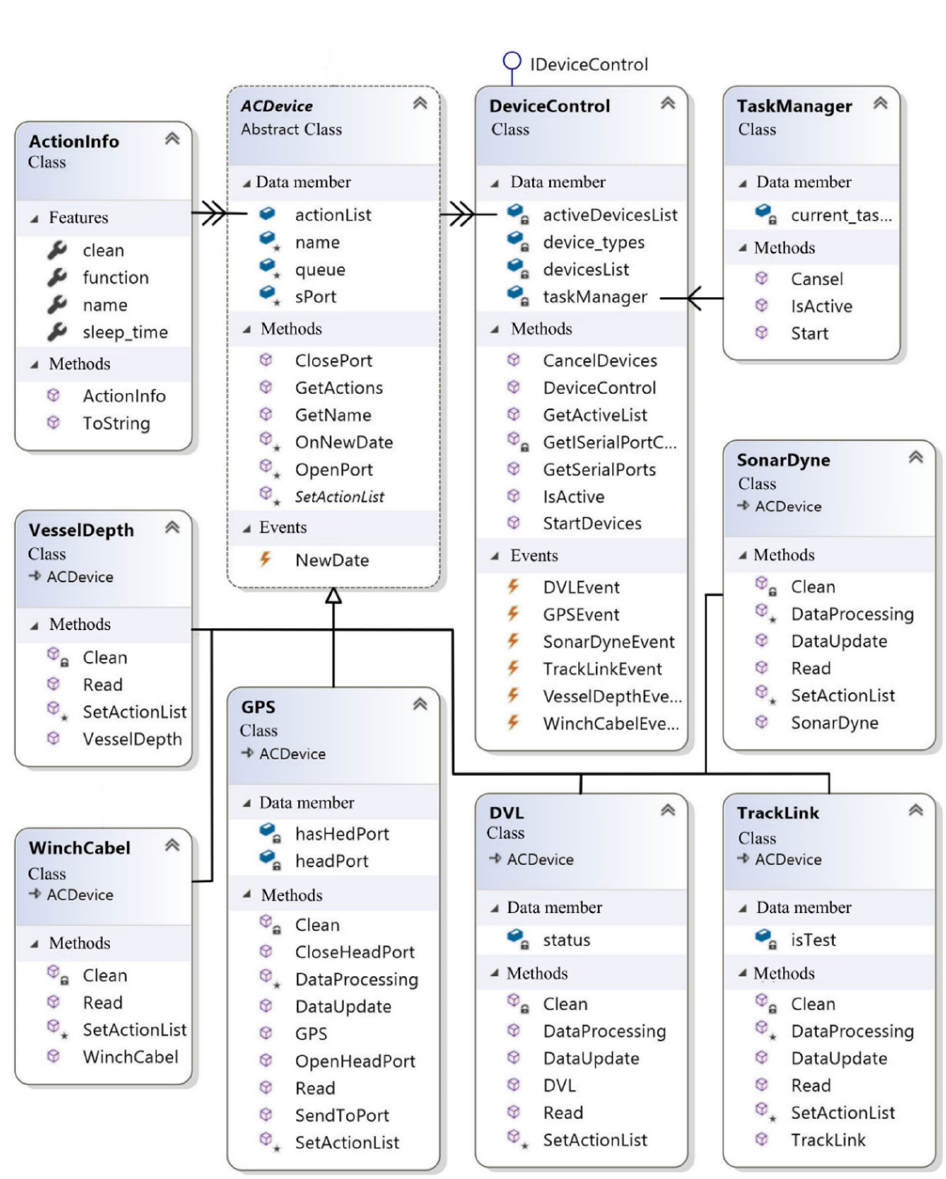
Figure 4. Diagram for the classes of the block of communication with external devices.